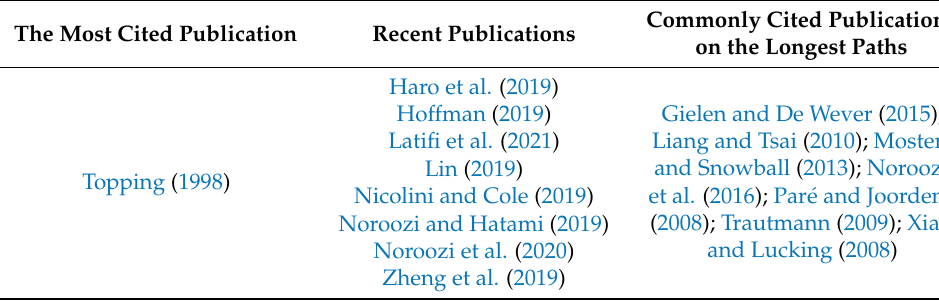
Table 6. Common citations in multiple longest paths between Topping (1998) and eight recent studies published in 2021 and